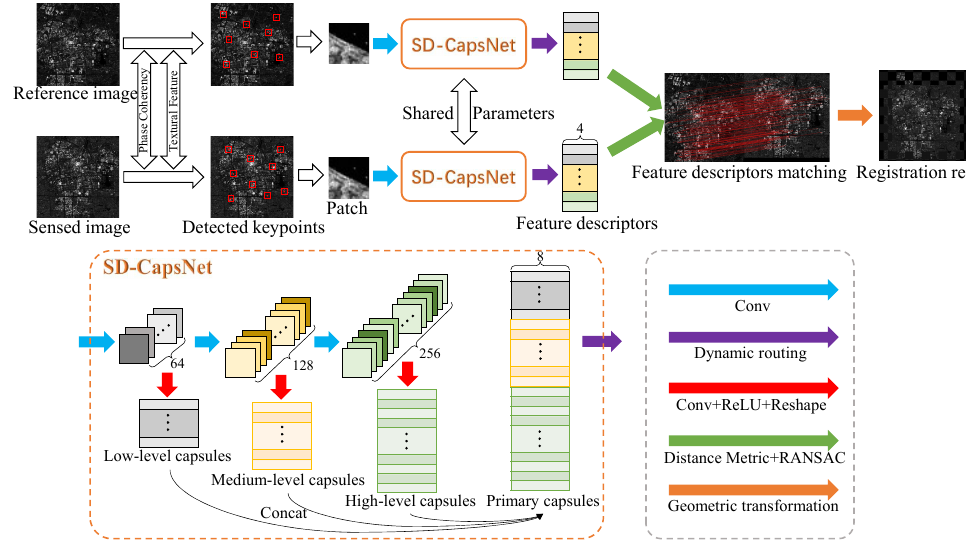
Figure 3. Schematic diagram of the proposed